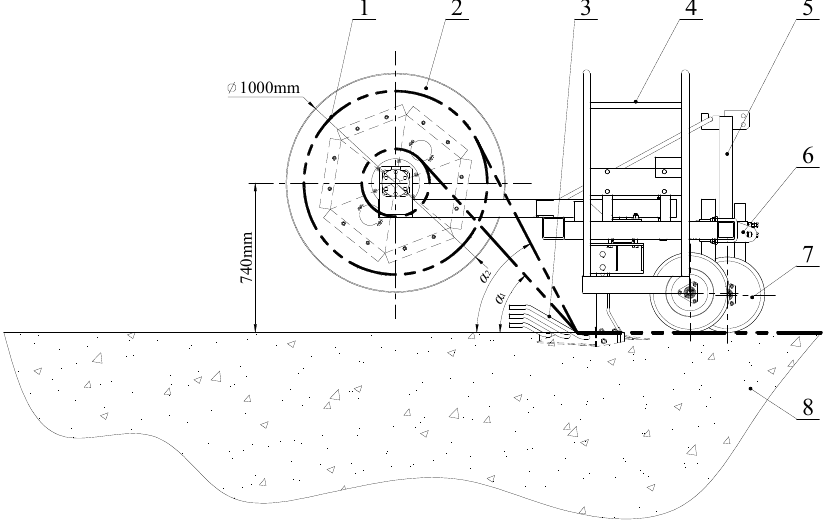
Figure 7. Operation process of the 1JRM-2000 curl-up film collector: 1—film, 2—film-curling mecha- nism, 3—film pick-up mechanism, 4—operation platform, 5—body frame, 6—traction mechanism, 7—deep limiter,